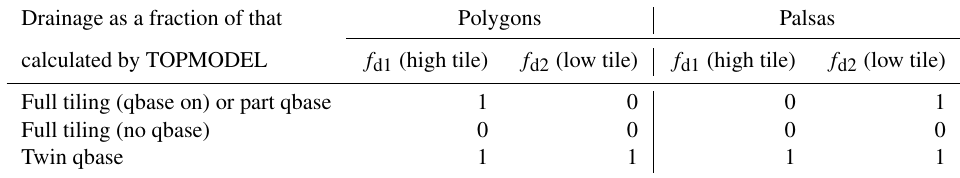
Table 3. Configurations of the parameters f d1 and f d2 , which determine the drainage as a fraction of that calculated by TOPMODEL for each tile. Drainage as a fraction of that Polygons Palsas calculated by TOPMODEL f d1 (high